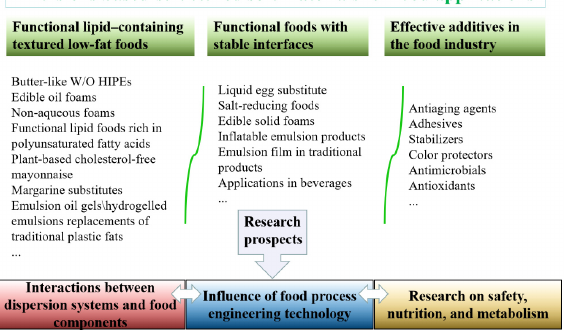
Figure 5. The key food-grade emulsion-based structured soft materials for food applications and their future research prospects. their future research 4.1.1. Development of Low-Fat Foods The pursuit of foods containing health lipids is mainly reflected in the development of low-fat foods, the replacement of foods that may contain trans -fatty acids, increases in